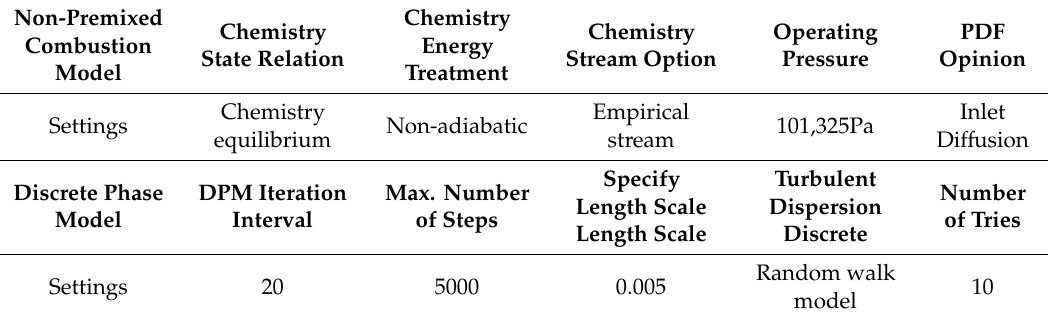
Table3. SettingsandparametersofNon-Premixedcombustionanddiscrete-phasemodel(DPM)models.